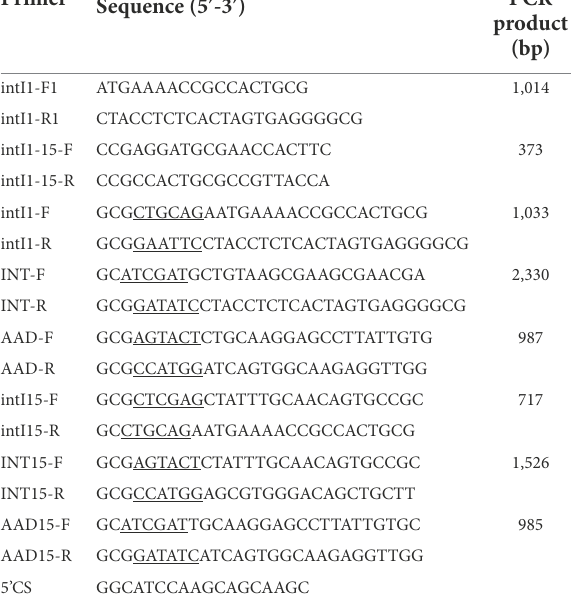
TABLE 1 Sequencing and PCR